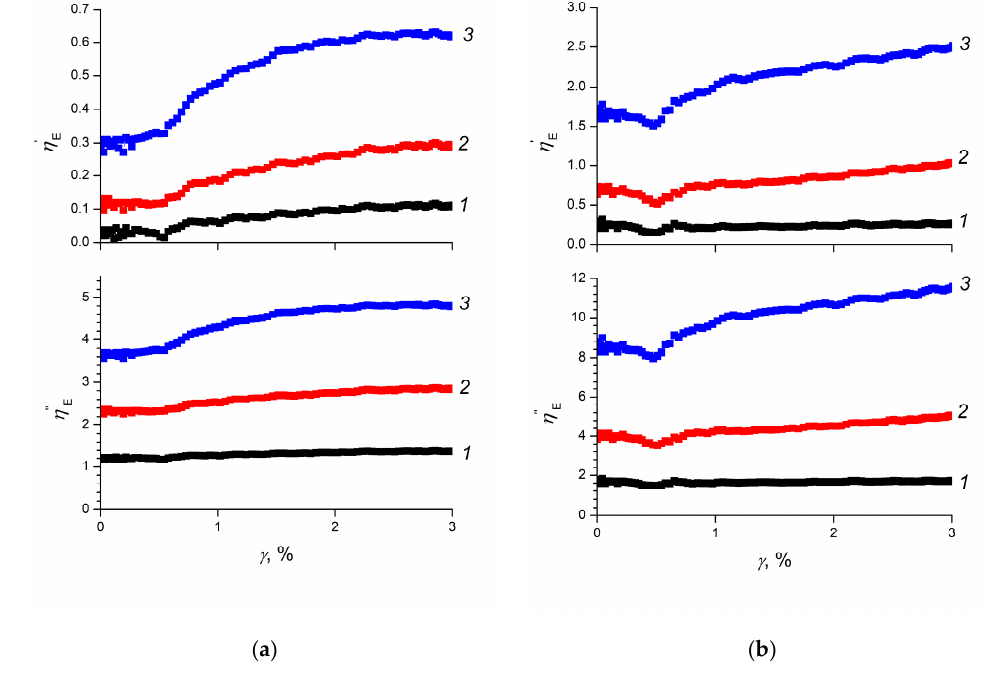
Figure 4. The electrorheological sensitivity of composite elastomers ( a ) ERE-0 and ( b ) ERE-5 with respect to storage ( η (cid:48) ) and loss ( η (cid:48)(cid:48) ) moduli as function of relative deformation at various strengths of an external electric field (1–0.4 kV/mm, 2–1.2 kV/mm, 3–2.0 kV/mm).